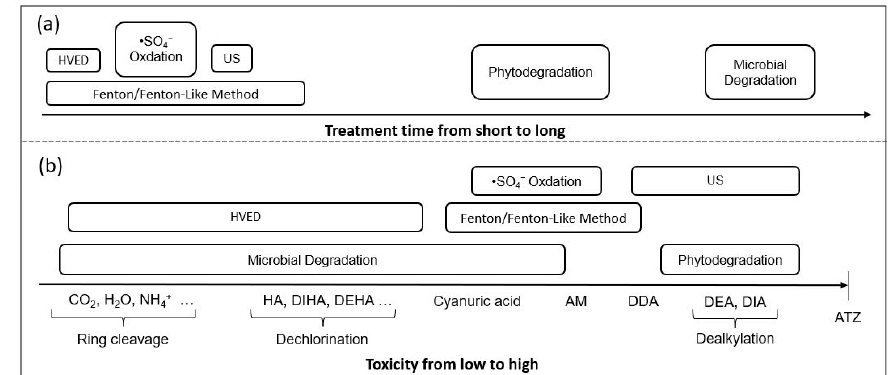
Figure 5. Comparison of different methods: ( a ) treatment time ( b ) product distribution.